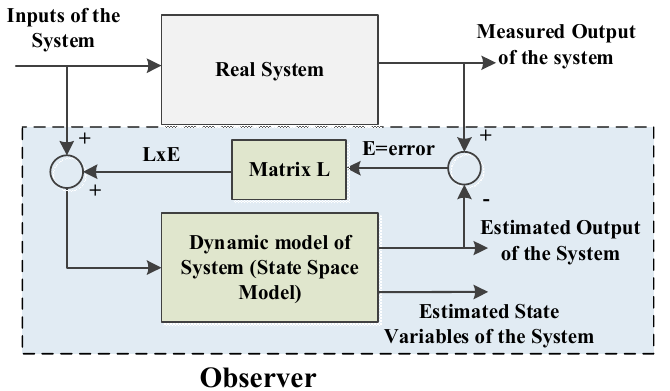
Figure 3. State-space variable observer and its operation mechanism beside the real